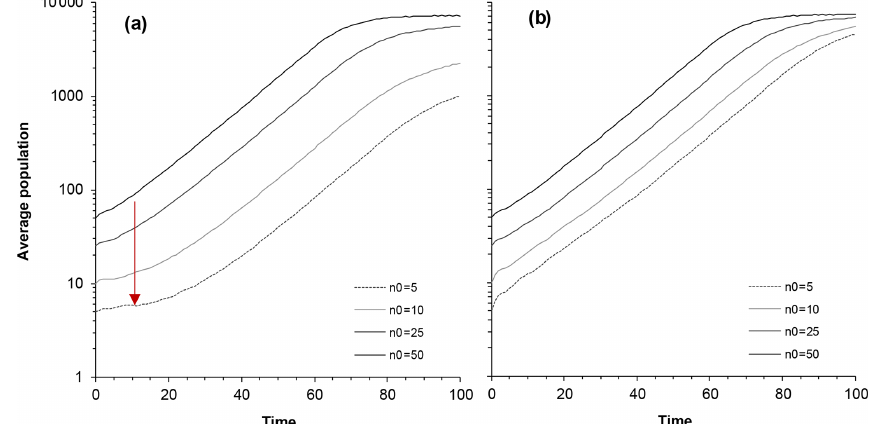
Figure 2. Model predictions for average population size as a function of time and different restocking (initial) population sizes: N 0 = 5, N 0 = 10, N 0 = 25, and N 0 = 50. (a) Population size average over all populations, including extinct ones. The depression in the initial phase (red arrow) reflects the Allee effect. (b) Average population size only for populations that eventually survive. Impact of catastrophe is 30 deaths; average time interval between catastrophes is 30 years (95% interval is 0.76 to 111 years); carrying capacity is 10000. (The vertical scale is logarithmic, so regular, density-independent growth should follow a straight line.)